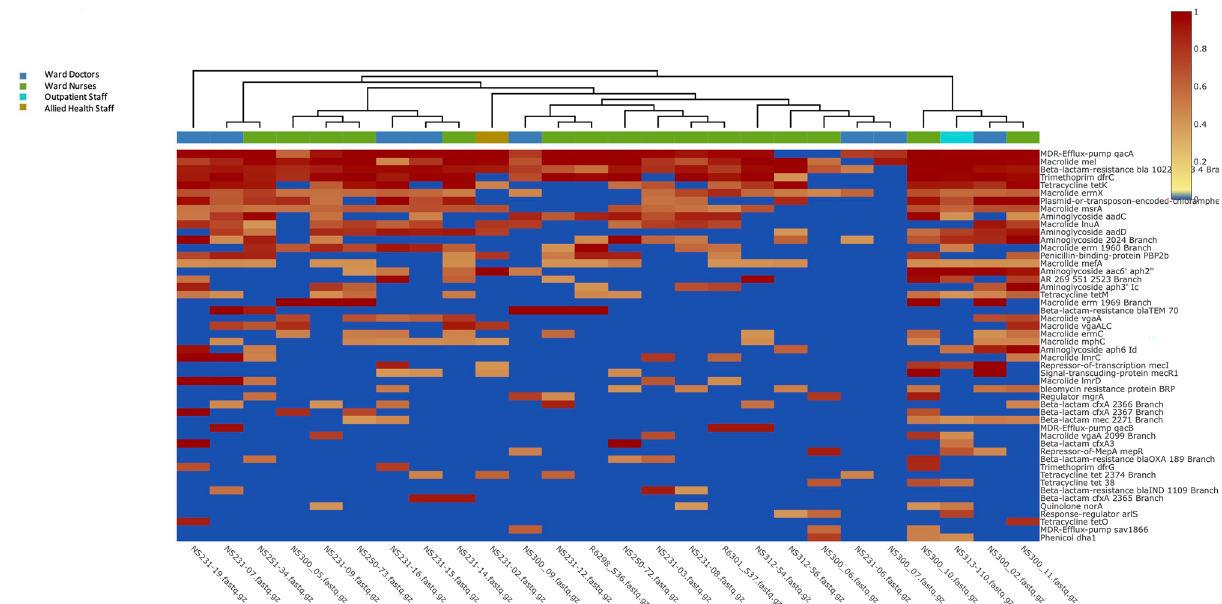
Figure 8. Heatmap representation of antibiotic resistant genes found on mobile phones owned by health care staff (heatmap clustered by staff